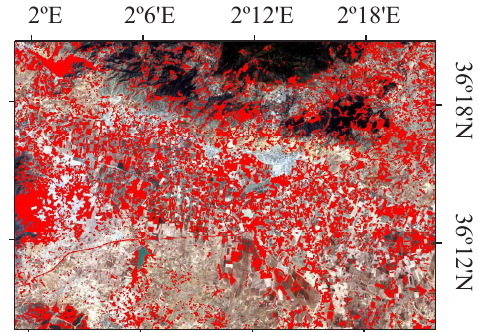
Figure 7: Pixels in red represent the changed areas detected by MSCVAPS method in the sub-area of